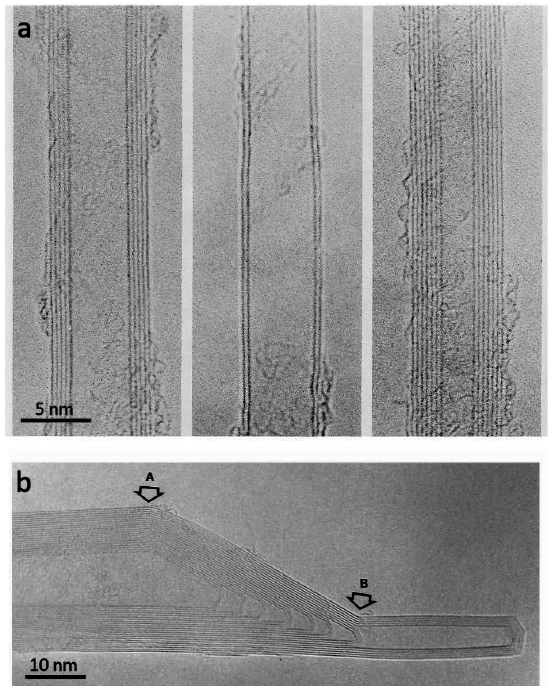
Figure 4. ( a ) Some of Iijima’s first images of multiwalled nanotubes. Reproduced with permission from [49]. Springer Nature, 1991; ( b ) Multiwalled nanotube cap. “A” indicates position of single pentagon; “B” indicates probable position of single heptagon. Reproduced with permission from [51].